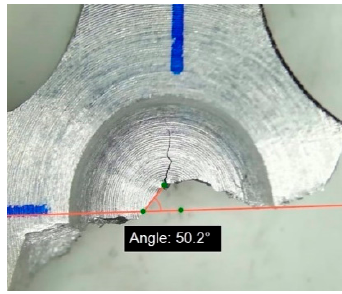
Figure 26. Cruciform C-T specimen failed after tension / tension (out-of-phase) biaxial UFT at VHCF [24].